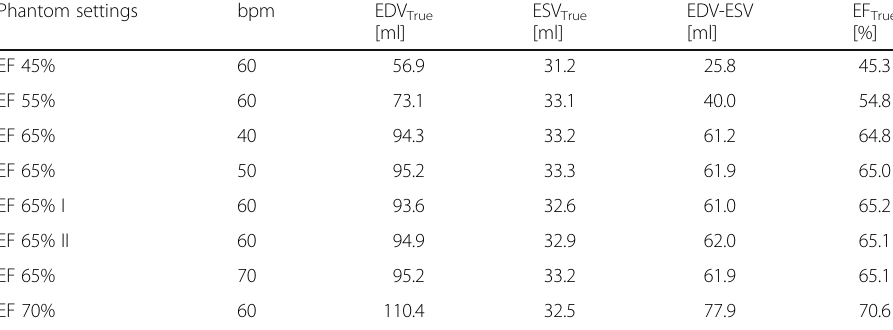
Table 1 ESV True , EDV True and EF True measured from gated CT images Phantom settings